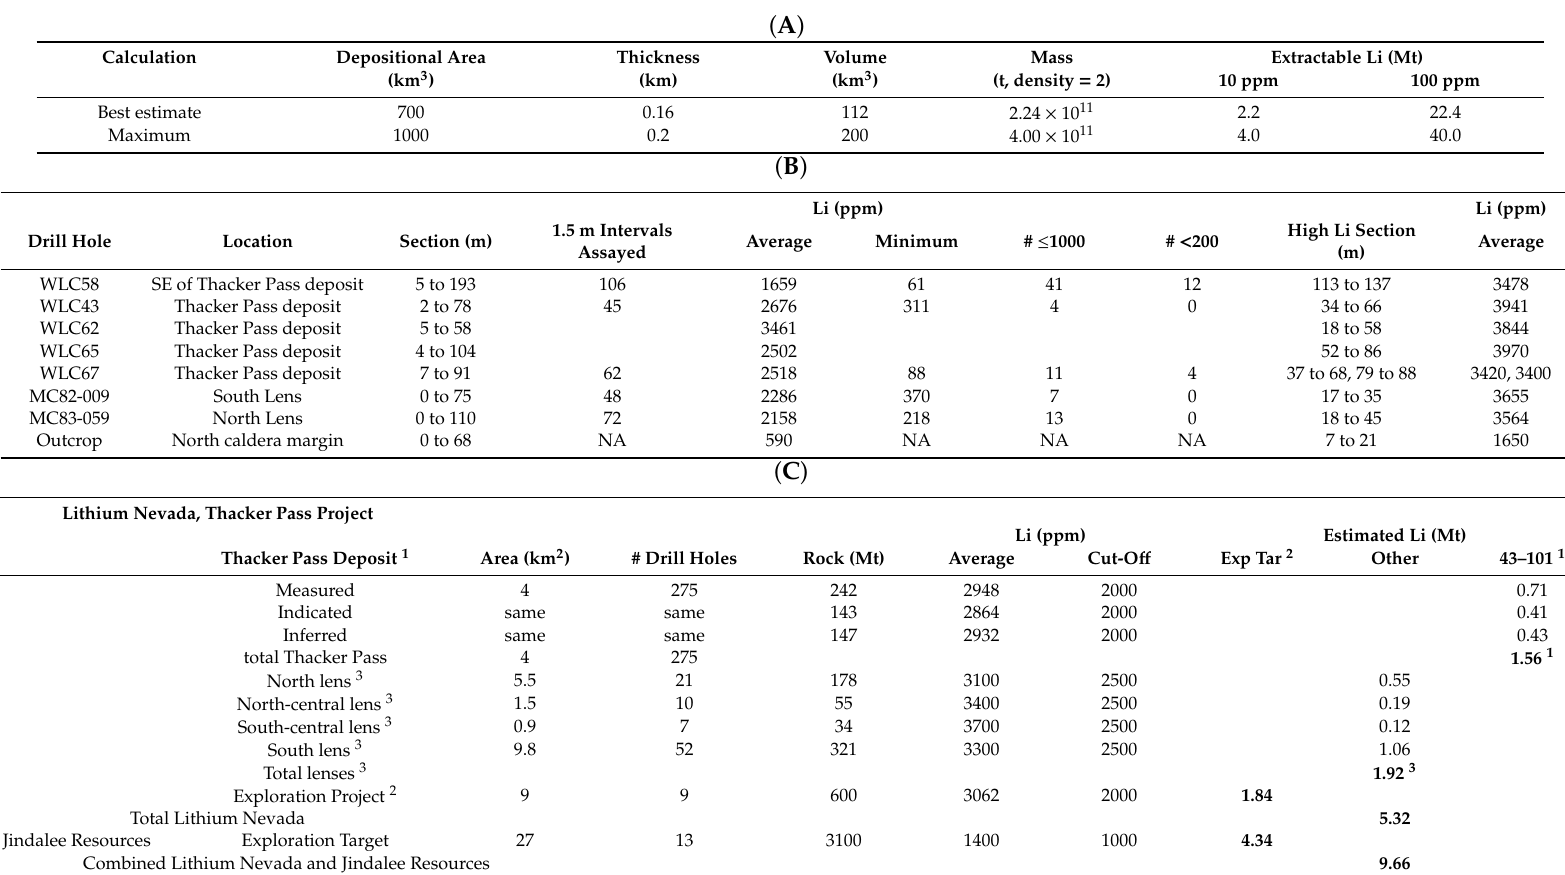
Table 3. ( A ) Lithium originally available from tu ff aceous sediments; ( B ) Lithium contents of drill hole and outcrop, McDermitt caldera; ( C ) Lithium contents of identified